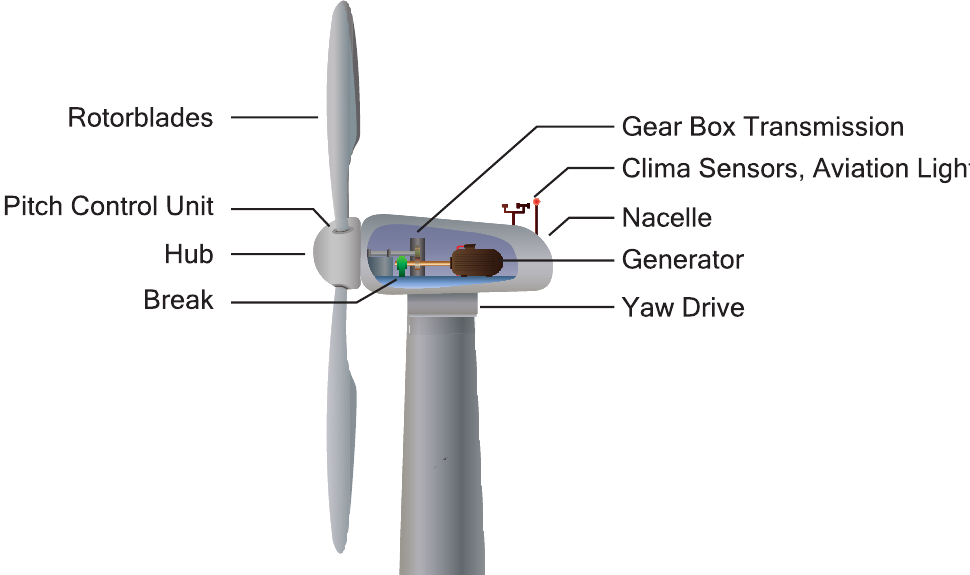
Figure 1. Main parts of a wind